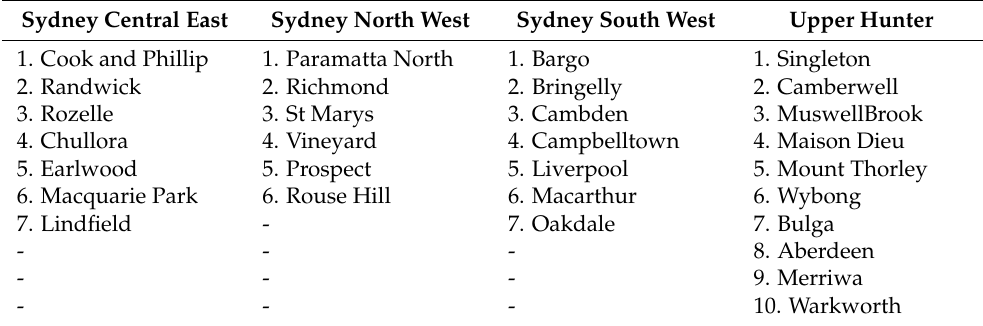
Table 1. Data collection points at various locations of Sydney Central East, North West, South West, and Upper